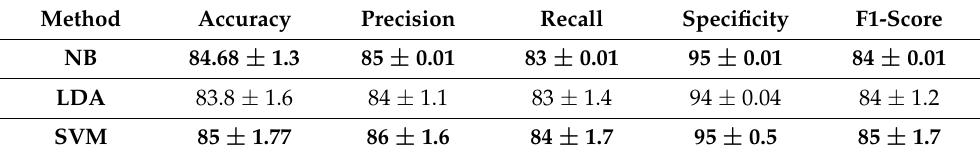
Table 2. Four-class classification performances of NB, LDA, and SVM when trained with fNIRS and behavioral features (i.e., GE cm , GE dm , and CQ). Each performance metric is represented in percentages (%) as the mean value across all runs ± standard deviation of the mean. Bold-typed results denote significantly higher performance of the corresponding algorithm with respect to the results when the algorithm is fed with fNIRS only features.